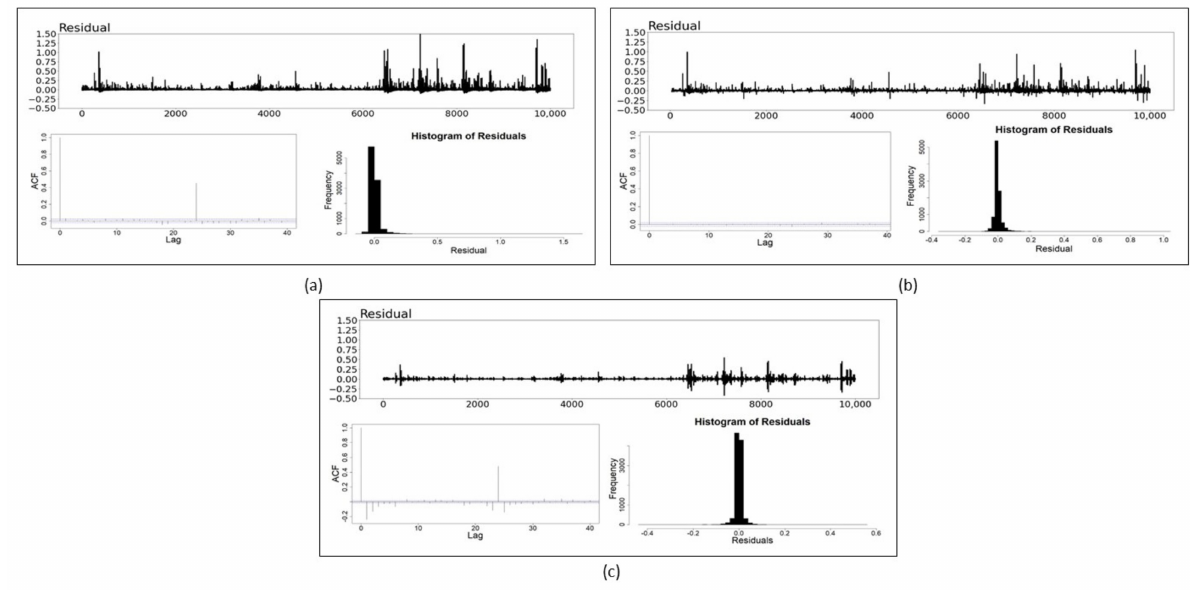
Figure 7. Residual plots, ACF plots and histograms of the: ( a ) GARCH (1,1) model; ( b ) NN model and ( c ) SS model for XRP. The blue dotted lines in ACF plots indicate the point of statistical significance.